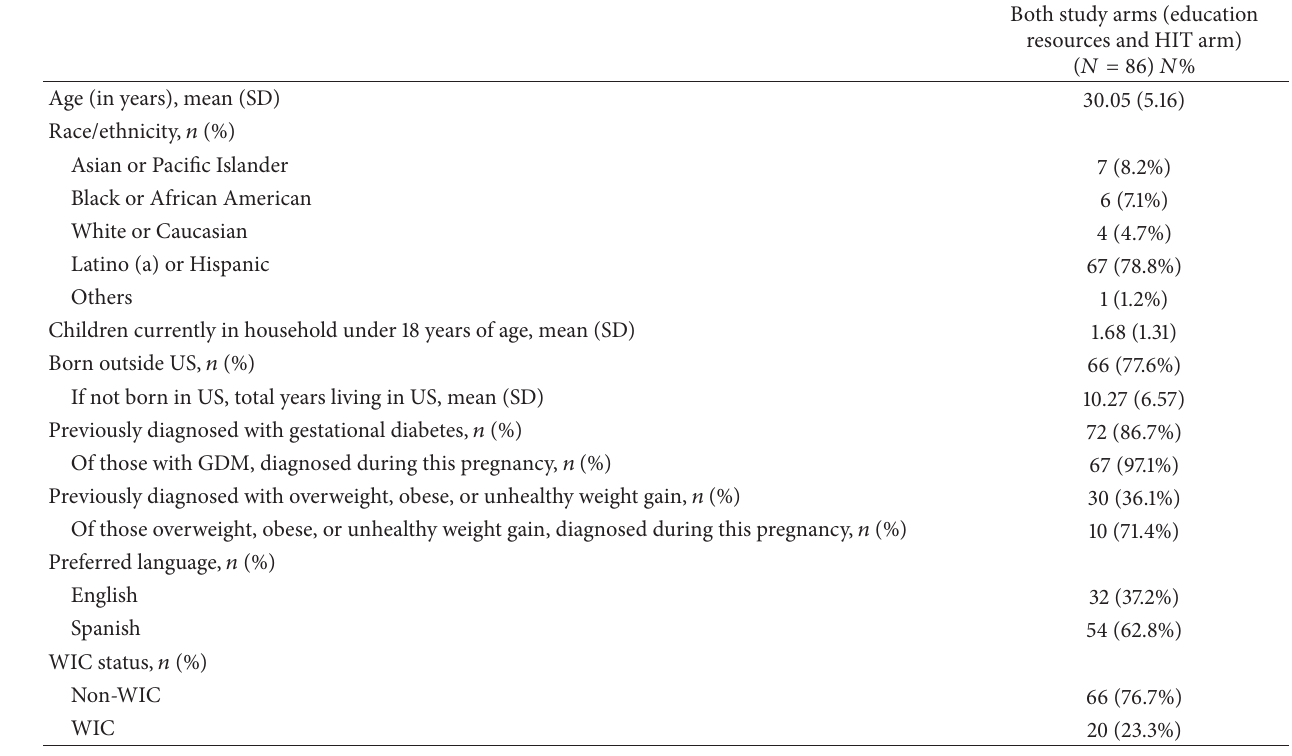
Table 1: Sociodemographic characteristics of currently enrolled or completed STAR MAMA participants ( 𝑁 = 86